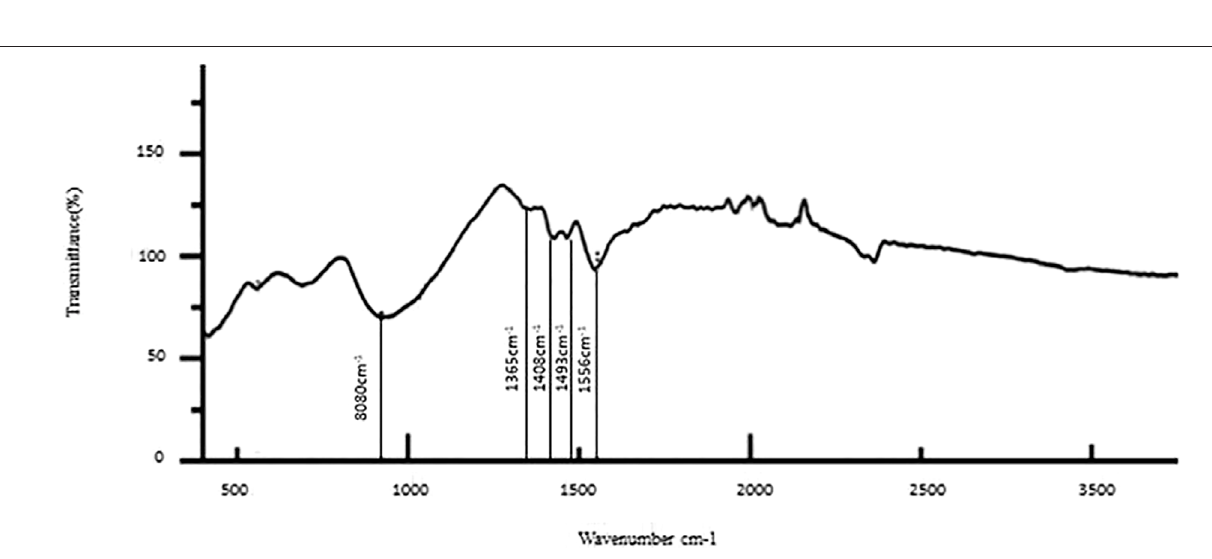
Frontiers in Bioengineering and Biotechnology |